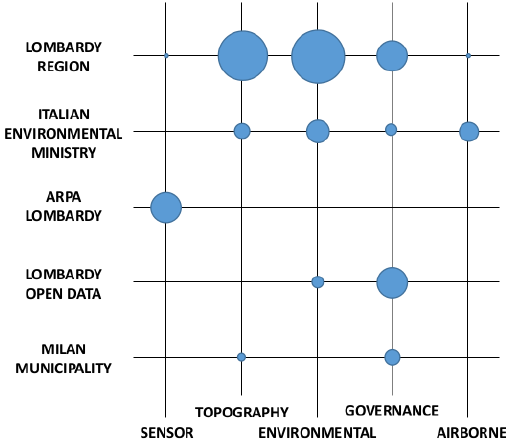
Figure 4. Proportion of open geodata available for Milan Municipality according to their category and